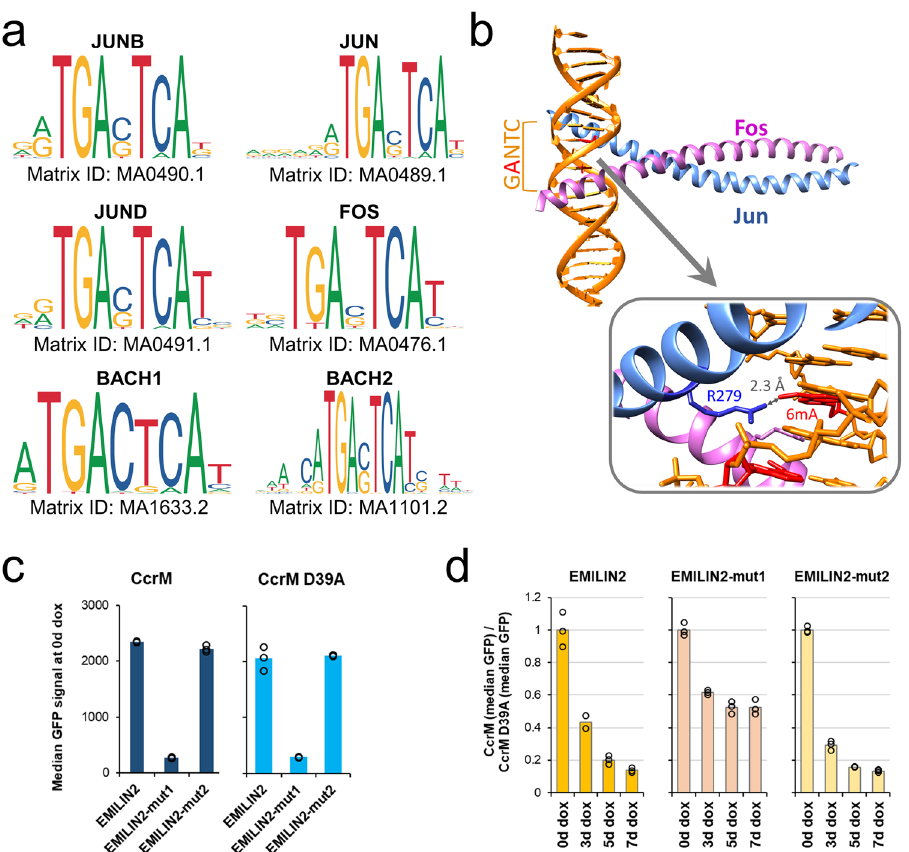
Fig. 6 m6dA-dependent downregulation of genes is potentially linked to loss of JUN TF binding. a Position weight matrices (PWM) of candidate TFs containing the CcrM target motif. PWMs were obtained from the JASPAR 2022 database (https://jaspar.genereg.net/). b Crystal structure of the Jun/Fos heterodimer (pdb: 1FOS) binding to DNA (orange). Deoxyadenine residues in the GANTC sequence on both strands of the model (red) were modi fi ed to m6dA. The distance between the amino group of R279 of JUN and the adjacent m6dA methyl group is indicated. c Flow cytometry results, showing the median GFP expression in cells containing different variants of the EMILIN2 promoter upstream of GFP: unaltered EMILIN2 promoter, A-to-G mutation in the putative JUN (TGANTCA) motif (mut1), or A-to-G mutation in a GANTC motif (mut2) lacking the surrounding T/A bases. d Flow cytometry analysis showing the changes of GFP expression for the different EMILIN2 promoter variants after CcrM induction. Ratios of the median GFP signals for CcrM and CcrM D39A were